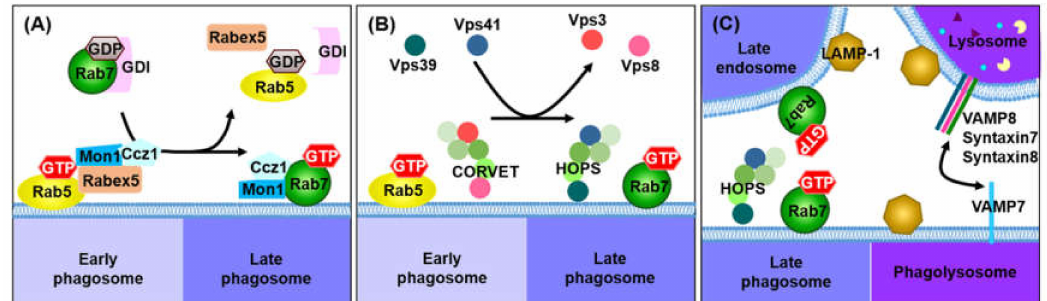
Figure 5. Transition from the early to the late phagosomes. ( A ) The transition of GTP-bound Rab5 to GTP-bound Rab7 is mediated by Mon1 and Ccz1. Mon1 and Ccz1 are recruited into early phagosomes to interact with Rab5. Mon1 binds to Rabex-5 to reduce Rab5 activity, and is then exchanged with Rabex-5 on early phagosomes. Mon1-Ccz1 acts as a Rab7 GEF, which induces Rab7 association and Rab5 dissociation. ( B ) The conversion of Rab5 to Rab7 is also mediated by the replacement of the CORVET complex with the HOPS complex. Vps3 and Vps8 of CORVET are exchanged by Vps39 and Vps41 of HOPS. ( C ) The HOPX complex enhances the interaction with Rab7-expressing late endosomes. Late phagosomes acquire LAMP-1 and LAMP-2 through fusion with late endosomes and lysosomes. Late phagosomes also exhibit strong interactions with late endosomes and lysosomes using SNAREs, including VAMP7, VAMP8, syntaxin7 and syntaxin8. SNARE proteins support the formation of phagolysosomes by tethering between late phagosomes and